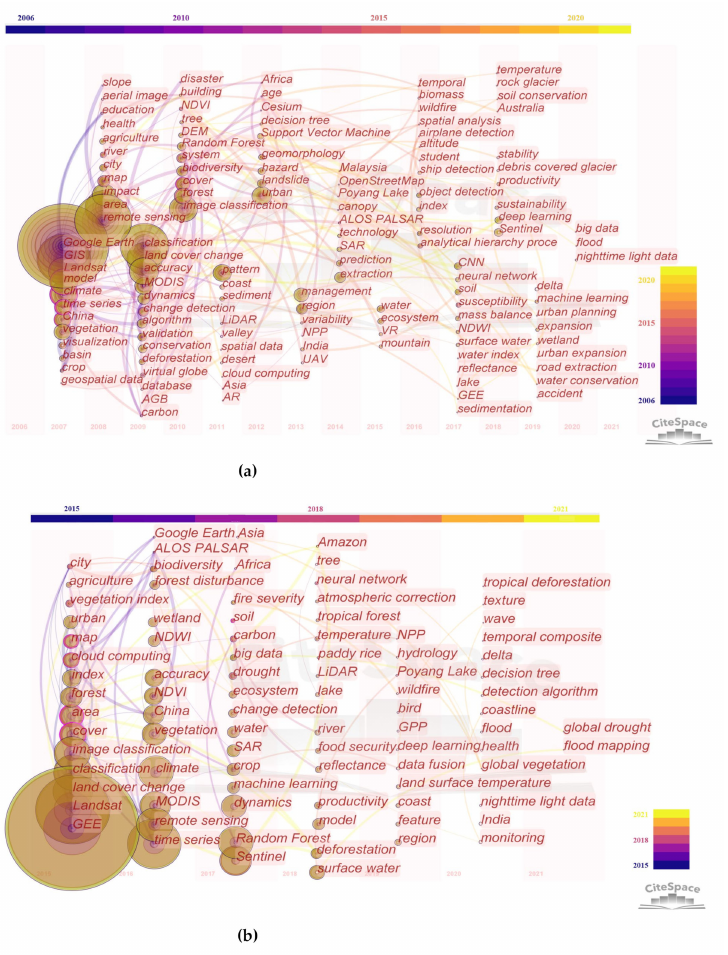
Figure 5. Co-occurrence keywords were used in relation to ( a ) GE and ( b ) GEE. The size of the node represents the frequency of the occurrence of the keyword, the connecting lines indicate the co-occurrence relationships for the keyword, and a purple outer circle indicates that the node is a key node (betweenness centrality >